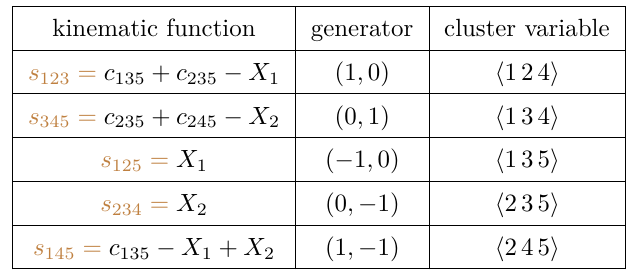
Figure 8. The polytope C (3 , 5) according to the “right” conventions; see table 4 and contrast with figure 1.